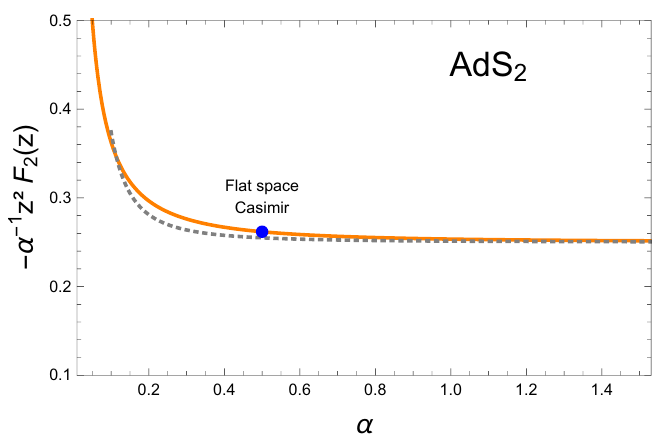
, the flat space 2